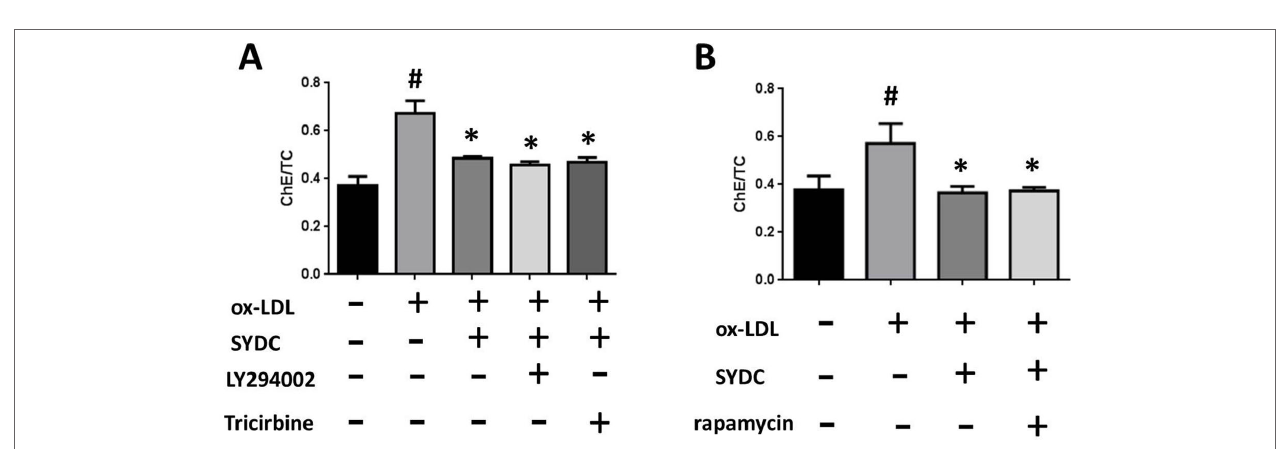
FIGURE 8 | The effect of SYDC on the PI3K/Akt/mTOR1 signaling pathway on preventing macrophage foam cell formation. (A) Effect of the PI3K inhibitor LY294002 (3.2 μmol/L) and the Akt inhibitor Tricibin (0.4 μmol/L) on ChE/TC levels in ox-LDL-stimulated macrophages after SYDC treatment (6.25 mg/ml). (B) Effect of the mTORC1 inhibitor Ramamycin (3.125 μmol/L) on ChE/TC levels in ox-LDL-stimulated macrophages after SYDC treatment (6.25 mg/ml). Data are expressed as the mean ± SD, n = 3; # P < 0.01 vs. blank control group, * P < 0.01 vs. the model control